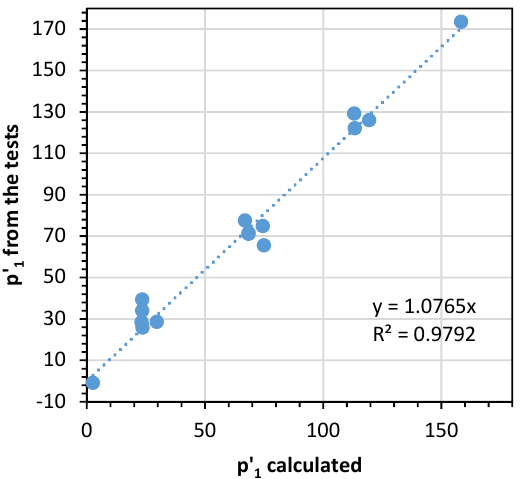
Figure 8. The relationship between the mean effective stress in the first cycle calculated based on Equation (16) and calculated form the cyclic triaxial tests.